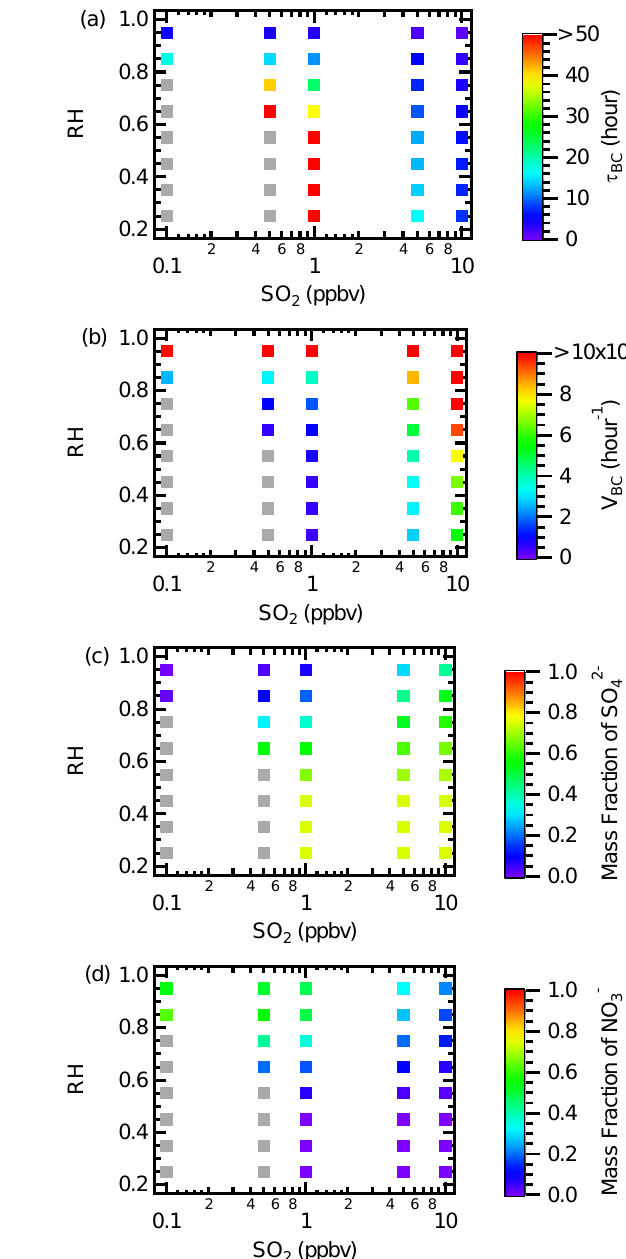
Fig. 5. Variations of (a) τ BC and (b) corresponding V BC as functions of both the initial SO 2 concentration and RH for a given initial BC mass concentration of 1.0µgm − 3 , NO x mixing ratio of 1.0ppbv, and NH 3 mixing ratio of 1.0ppbv for a lognormal BC size distribu- tion with a D m of 175nm and σ of 1.5 at T of 278K at noontime. Mass fractions of (c) SO 2 − and (d) NO − in condensed materials on 4 3 BC particles for each τ BC shown in Fig. 5a. Note that τ BC values greater than 120h are indicated in